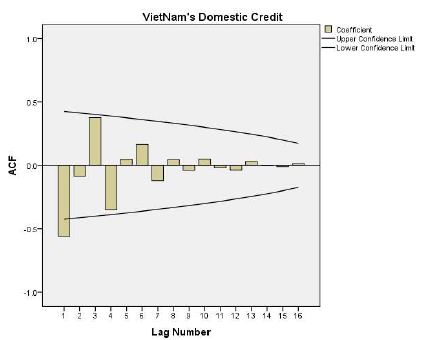
Fig. 5. Vietnam’s Series Autocorrelation Plots (The Box - Jenkins Method, (q=1)